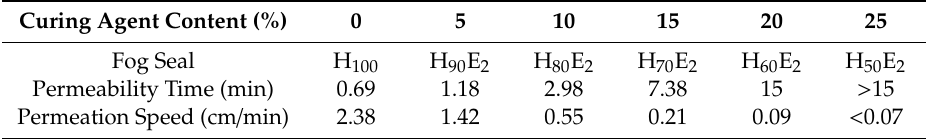
Table 4. Permeability under di ff erent dosages of curing